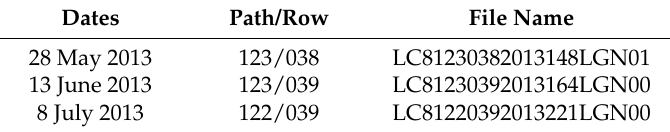
Table 1. Landsat 8 images used in this study.